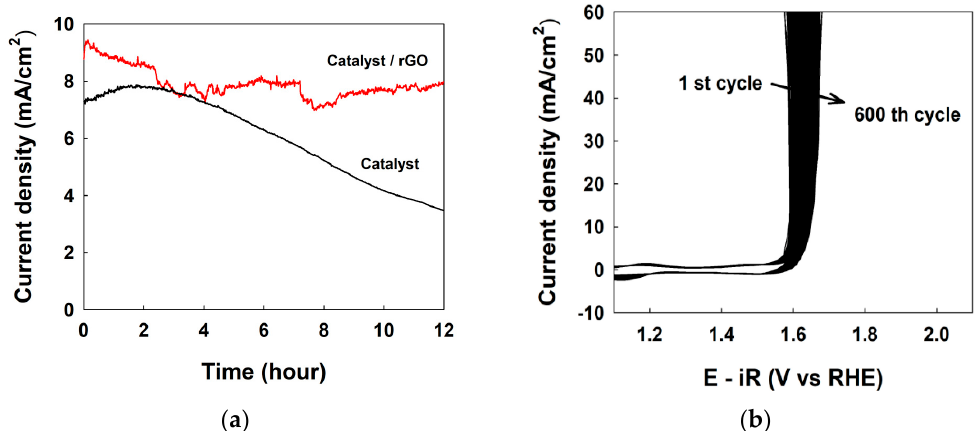
Figure 3. Durability test of electrocatalysts: ( a ) chronoamperograms of the catalyst/rGO composite-modified (red) and catalyst-modified (black) GCEs during the OER. ( b ) Cyclic voltammograms obtained for the catalyst/rGO composite-modified GCE with multiple segments. Scan rate was 0.1 V/s.